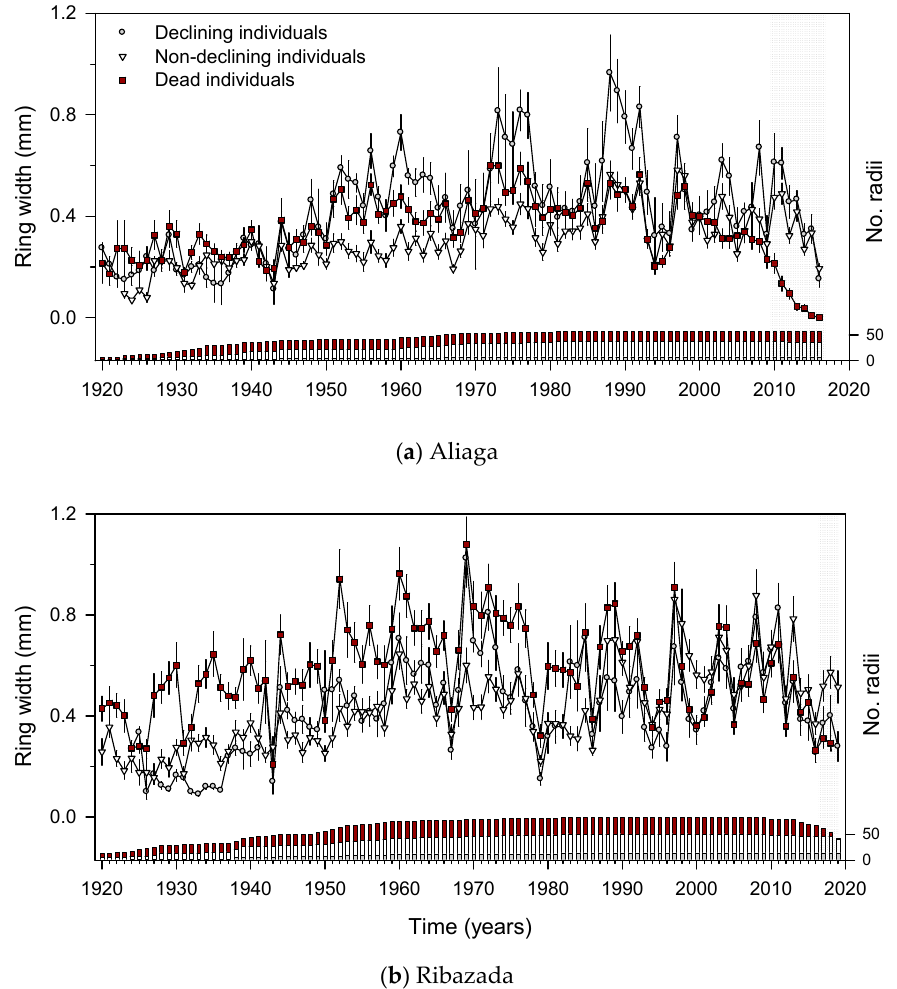
Figure 3. Growth data of junipers in the ( a ) Aliaga and ( b ) Ribazada study sites considering three health classes. Values are means ± SE. Growth rates differed significantly ( p < 0.05) among health classes in the periods highlighted by grey shading. The bars show the number of junipers analyzed per year (right y axes) using the same fill colors as ring-width mean series.